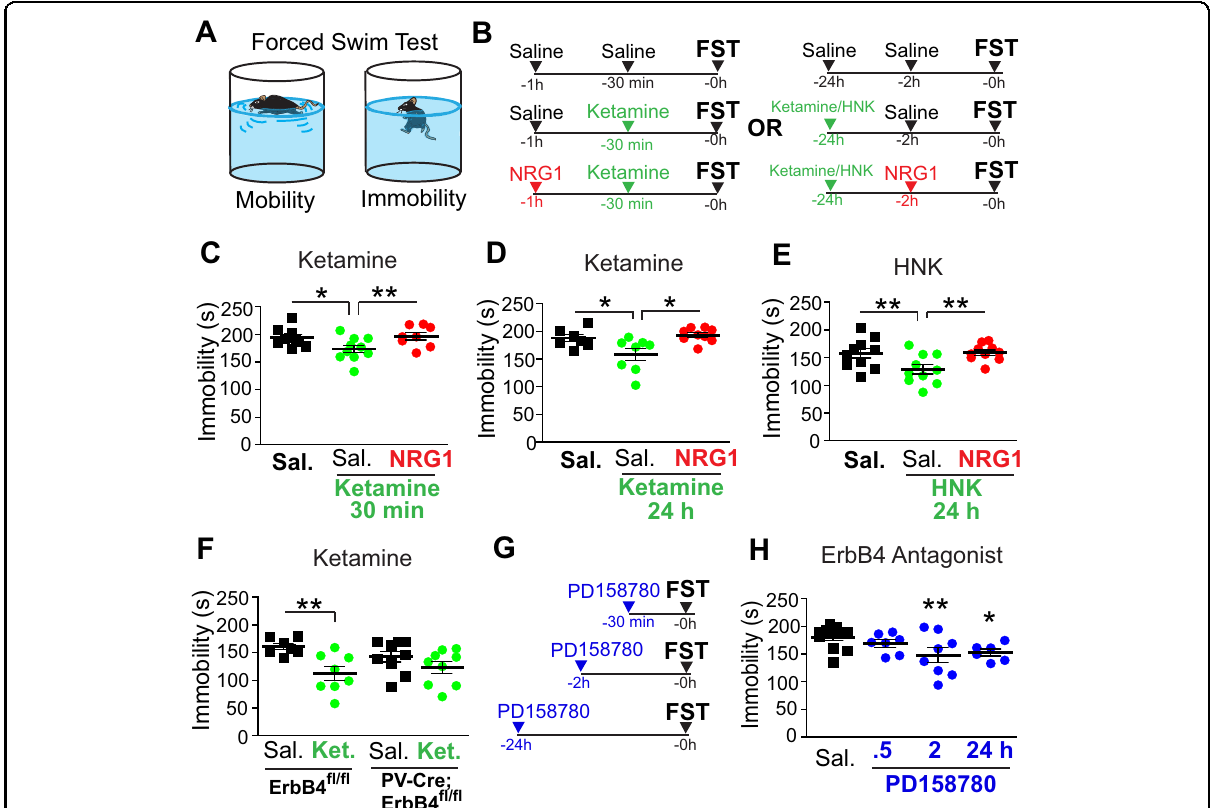
Fig. 1 Antidepressant effects of subanesthetic ketamine depend on NRG1/ErbB4 signaling. A A schematic illustration of the forced swim test (FST) which was used to determine the dependence of the antidepressant effect of ketamine on NRG1/ErbB4 signaling. B Schematics for the experimental timelines (30 min or 24 h after treatment) for ketamine and HNK (left and right). C Wild-type mice were treated with saline ( n = 7), ketamine (10 mg/kg; s.c.)( n = 8), or ketamine plus NRG1 (1 µg/mouse)( n = 9) and were then subjected to the FST 30 min later. Immobility times are shown (One-way ANOVA: overall p = 0.0069. Two-sample t test: ketamine + saline vs saline p = 0.0411, ketamine + NRG1 vs ketamine + saline p = 0.0066; mean ± SEM). D Wild-type mice were treated with saline ( n = 10), ketamine (10 mg/kg; s.c.)( n = 10), or ketamine plus NRG1 (1 µg/mouse)( n = 10) and were subjected to the FST 24 hours later (One-way ANOVA: overall p = 0.0289. Two-sample t test: ketamine + saline vs saline p = 0.0257, ketamine + NRG1 vs ketamine + saline p = 0.0351; mean ± SEM). E Wild-type mice were treated with saline ( n = 11), HNK (10 mg/kg; s.c.)( n = 14), or HNK plus NRG1 (1 µg/mouse)( n = 10) and were subjected to the FST 24 h later (One-way ANOVA: overall p = 0.0031. Two-sample t test: HNK + saline vs saline p = 0.0076, HNK + NRG1 vs HNK + saline p = 0.0071; mean ± SEM). F Control ErbB4 fl / fl mice were treated with saline ( n = 7) or ketamine (10 mg/kg; s.c.)( n = 8) and PV-Cre; ErbB4 fl / fl mice were treated with saline ( n = 9) or ketamine (10 mg/kg; s.c.)( n = 9) and tested on the FST 24 hours later (Two-way ANOVA: overall p = 0.0033. Two-sample t test: saline vs ketamine (ErbB4 fl / fl ) p = 0.0041, saline vs ketamine (PV-Cre; ErbB4 fl / fl ) p = n.s.; mean ± SEM). We fi nd no signi fi cant effect of genotype. G Schematics for the experimental timelines for the ErbB4 antagonist PD158780. H Wild-type mice were treated with vehicle ( n = 10) or PD158780 (10 mg/kg; s.c.) and subjected to the FST 30 min ( n = 7), 2 h ( n = 8) or 24 h ( n = 6) later (One- way ANOVA: overall p = 0.0421. Two-sample t test: PD158780 vs saline, 30 min. p = n.s., 2 h p = 0.0098, 24 h p = 0.0395; mean ±